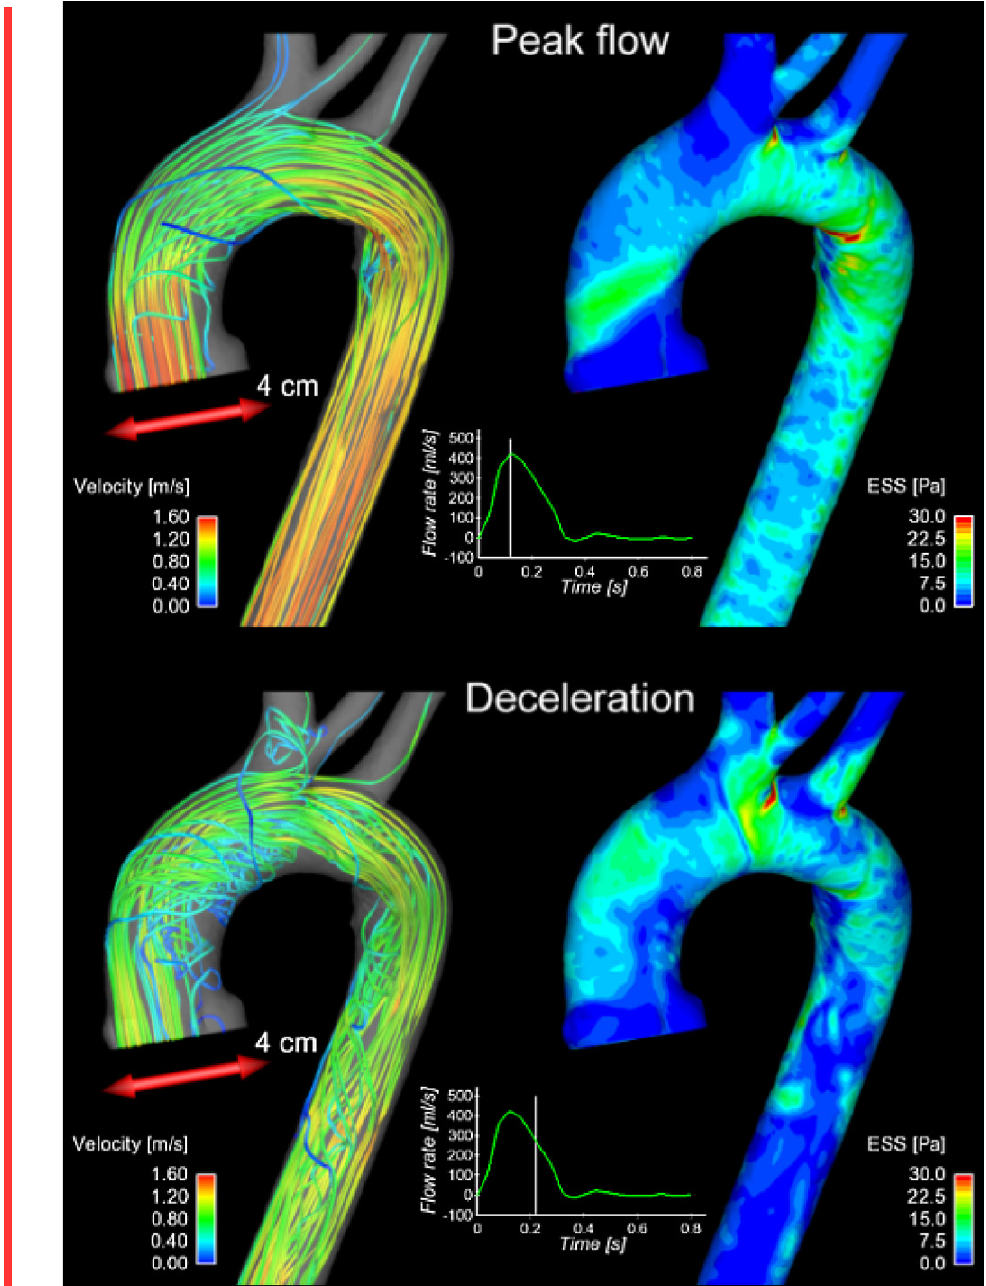
Figure. 3 Example of blood flow simulation results. Streamline representation of blood flow patterns (left) and ESS maps (right) at two different phases in a cardiac cycle. At peak flow, streamlines are straight through the aorta whereas they show strongly swirling patterns in the deceleration